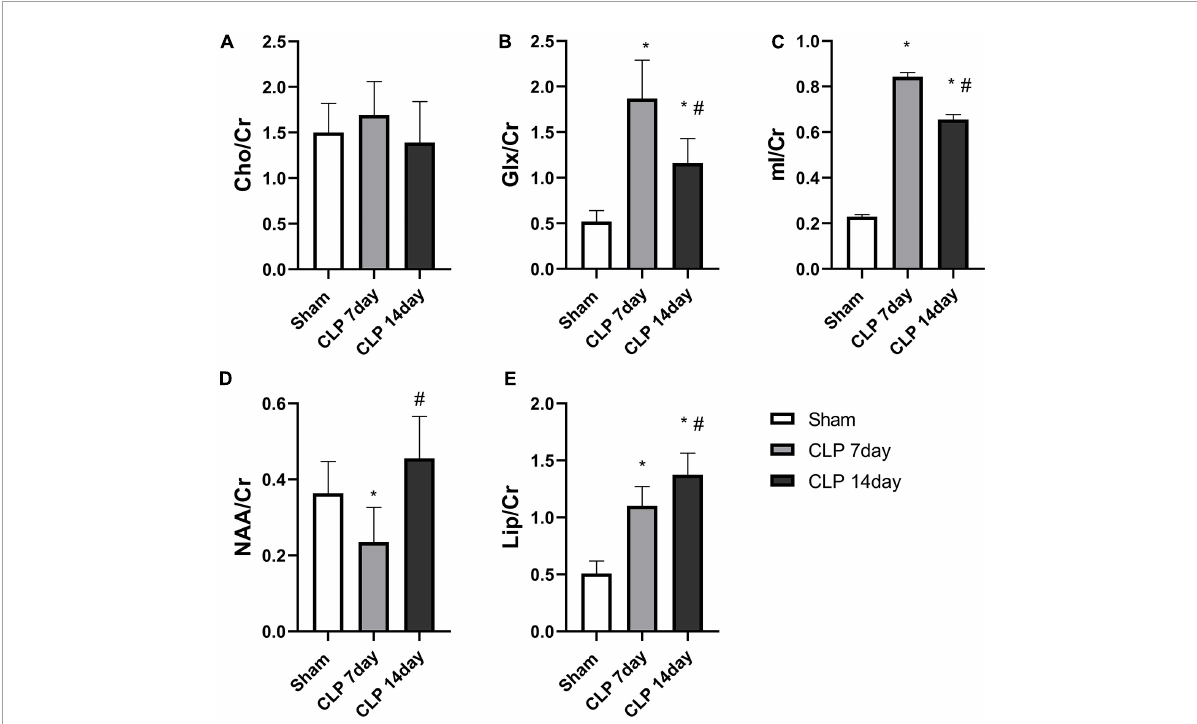
FIGURE3 Metabolite analysis among the three groups. There was no obvious difference in the (A) Cho/Cr ratio among the groups ( p > 0.05, analyzed by one-way ANOVA, n = 8); The Glx/Cr (B) and mI/Cr ratios (C) were significantly increased in the hippocampi of day 7 post CLP group, but were obviously lower in day 14 post group. (D) NAA/Cr ratios in the right hippocampus generally followed the rule of “decreased-enhancement” post CLP surgery. (E) Lip/Cr ratios increased gradually post CLP surgery (* p < 0.05, compared with sham group, # p < 0.05, compared with day 7 post CLP group, analyzed by one-way ANOVA) ( n = 8. Data are expressed as the mean ±